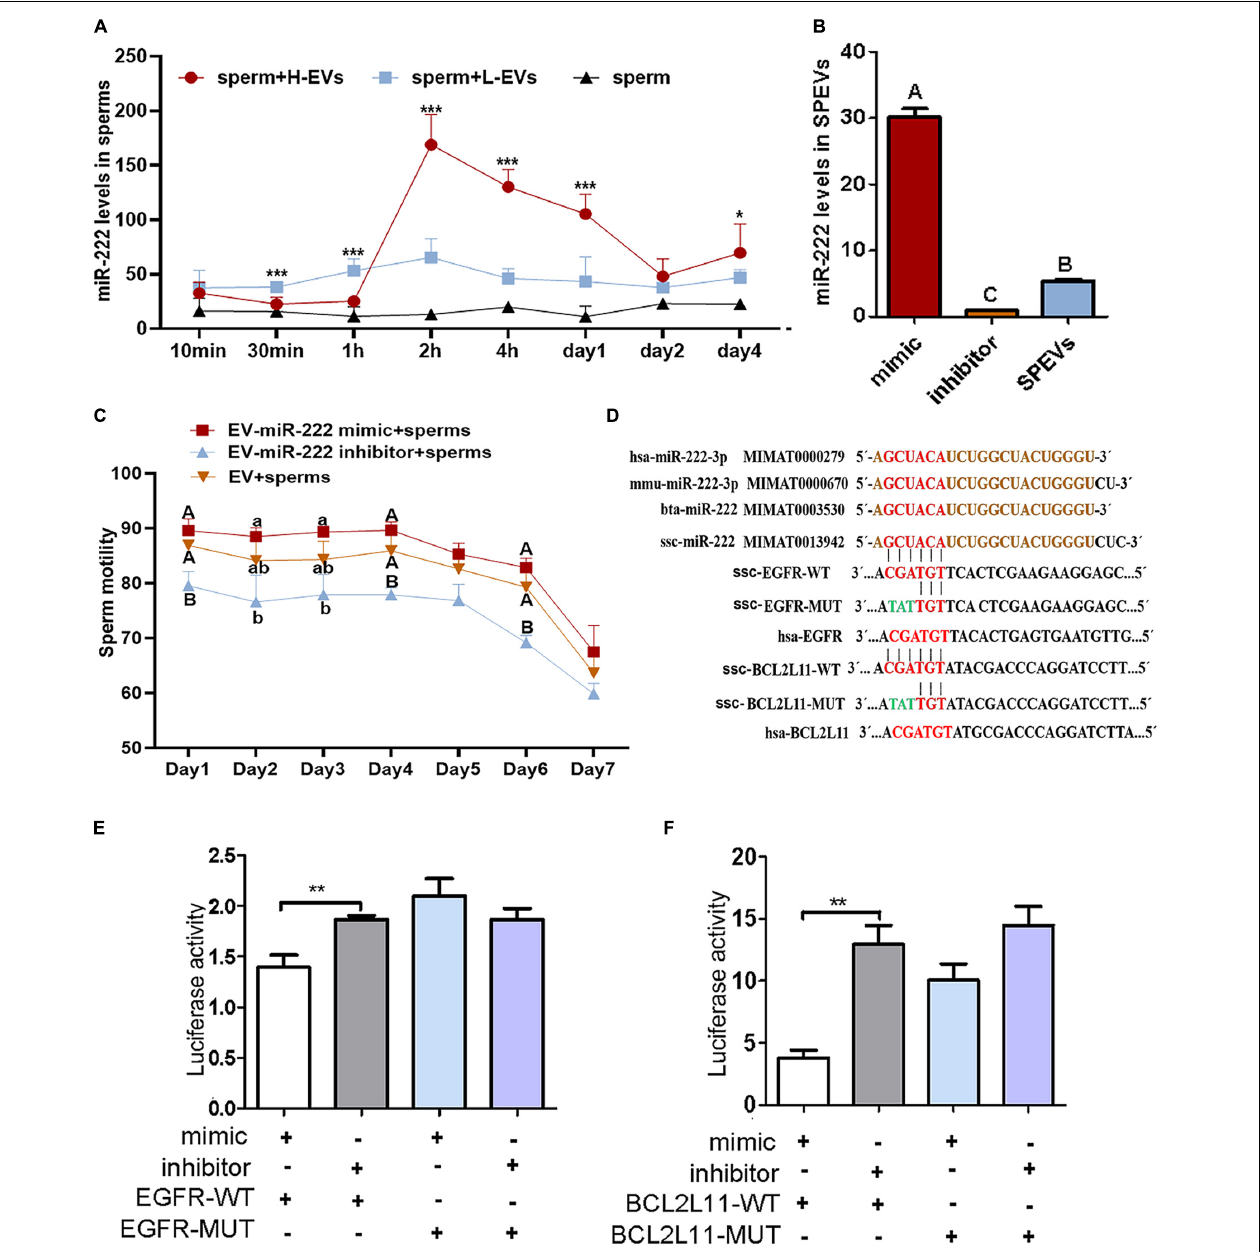
FIGURE 4 | miR-222 targets EGFR and BCL2L11 . (A) The relative miR-222 levels in sperm from healthy boars that were incubated with H-SPEVs and L-SPEVs, respectively. (B) The efficiency of electroporation was determined by qPCR. (C) The total motility of sperm incubated with EV-miR-222 mimic, EV-miR-222 inhibitor and SPEV-NC, respectively. (D) The sequence of miR-222 is conserved in many species. The predicted target-binding sites between miR-222 and EGFR and between miR-222 and BCL2L11 are shown. (E) A luciferase activity assay showed that miR-222 targets the EGFR 3 (cid:48) UTR. (F) A luciferase activity assay showed that miR-222 targets the BCL2L11 3 (cid:48) UTR. * P ≤ 0.05, ** P < 0.01, *** P ≤ 0.001 (Student’s t -test), different capital letters indicate significantly different values at P ≤ 0.01, different lowercase letters indicate significantly different values at P ≤ 0.05 (one-way ANOVA), n = 3 for each